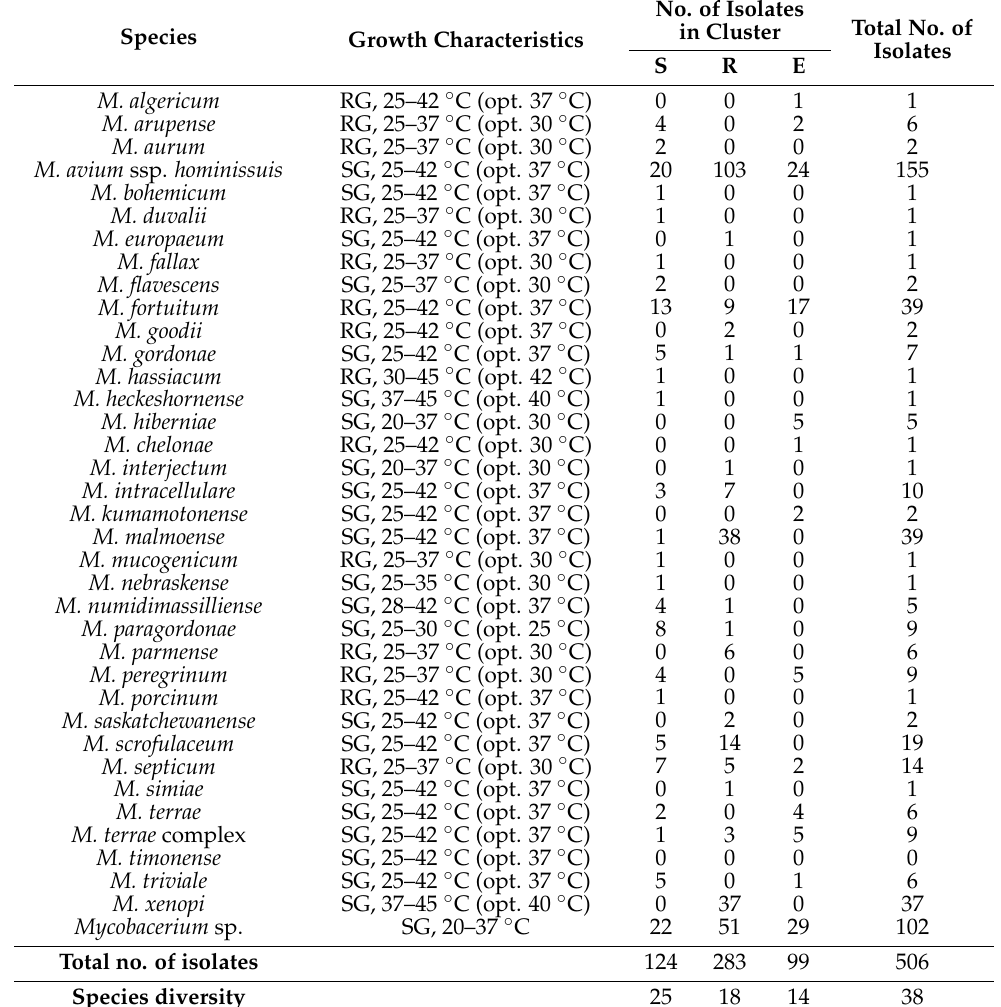
Table interpretation. Cluster S = soil and water sediments, Cluster R = peat and plant material, Cluster E = faeces and animals’ samples, RG = rapidly growing, SG = slowly growing, opt. = optimum.